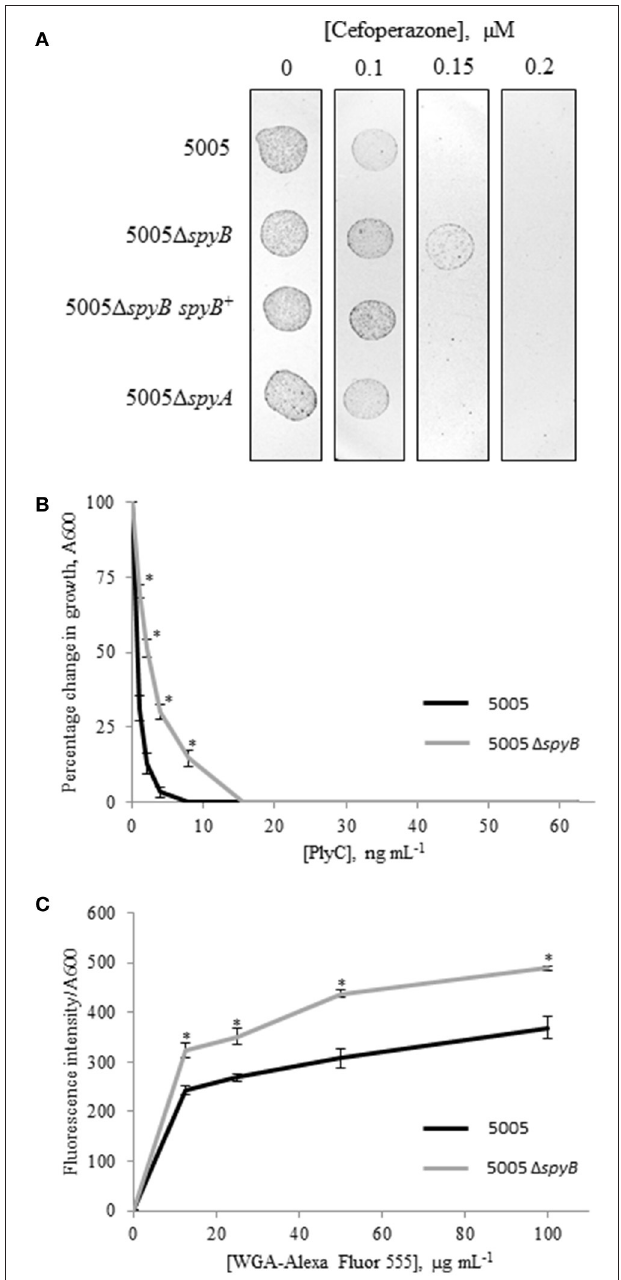
FIGURE 3 | Phenotypic analysis of 5005 1 spyB . (A) SpyB deficiency promotes resistance to cefoperazone. MGAS5005 strains were grown in CDM to middle exponential phase, diluted in PBS (10 − 2 dilution) and then plated on THY agar supplied with 0, 0.1, 0.15, and 0.2 µ M cefoperazone in triplicate. This result is representative of five independent experiments ( P = 0, t- test). (B) SpyB deficiency decreases the sensitivity of MGAS5005 to the PG hydrolase PlyC. MGAS5005 and 5005 1 spyB at middle exponential phase were measured for growth at 600 nm following 60 min incubation in the presence of various concentrations of PlyC (0–62.5 ng mL − 1 ). The average percentage change in growth ± standard deviation for three replicates is shown, the asterisk indicates values that are statistically different ( p < 0.01) from WT